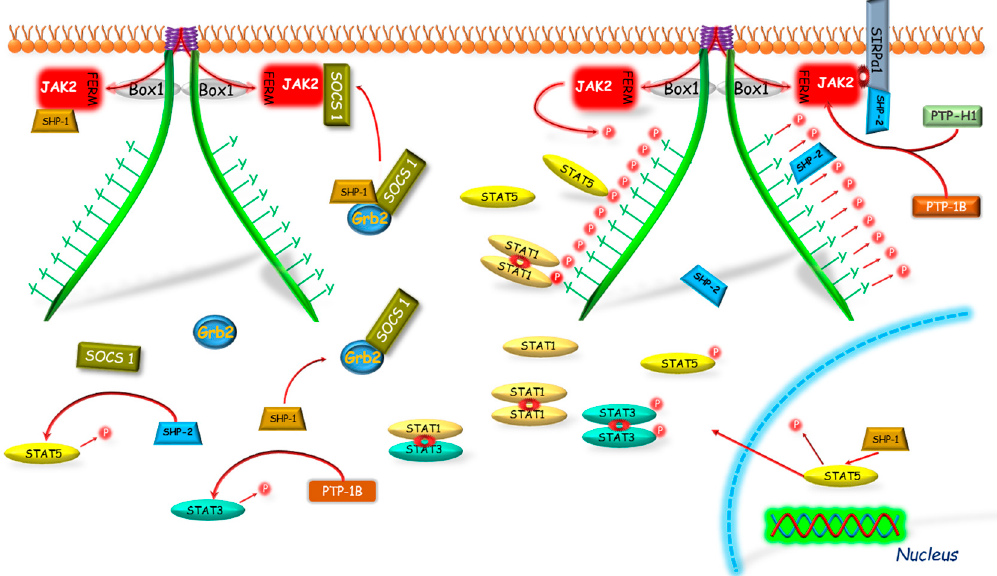
Figure 5. GHR-JAK2-STAT pathway inhibition mediated by PTP-1B, SHP-1, SHP2 and SIRP α 1. PTP-1B dephosphorylates residual tyrosines of JAK2, GHR, STAT3 or STAT5. PTP-H1 dephosphorylates GHR acting through the JAK2 activity down-regulation. SHP-1 mechanism of action: direct dephosphorylation of JAK2; targeting of the SOCS1–Grb2 complex to JAK2; dephosphorylation